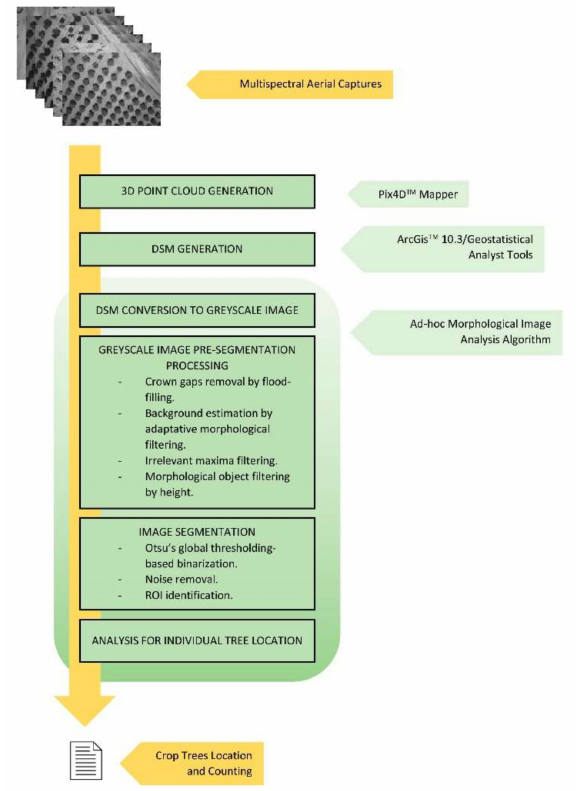
Figure 3. Representative diagram of the methodology proposed for detecting and counting crop trees from multispectral aerial